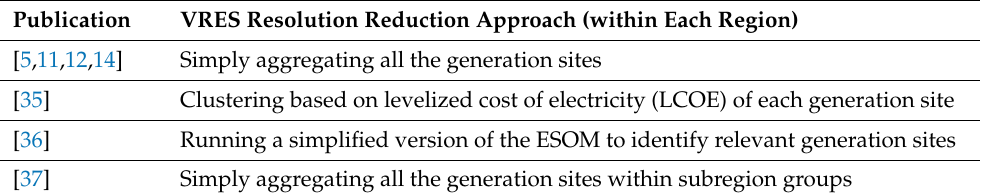
Table 2. The VRES resolutionreduction approaches applied to energy system optimization models (ESOMs) in the previous